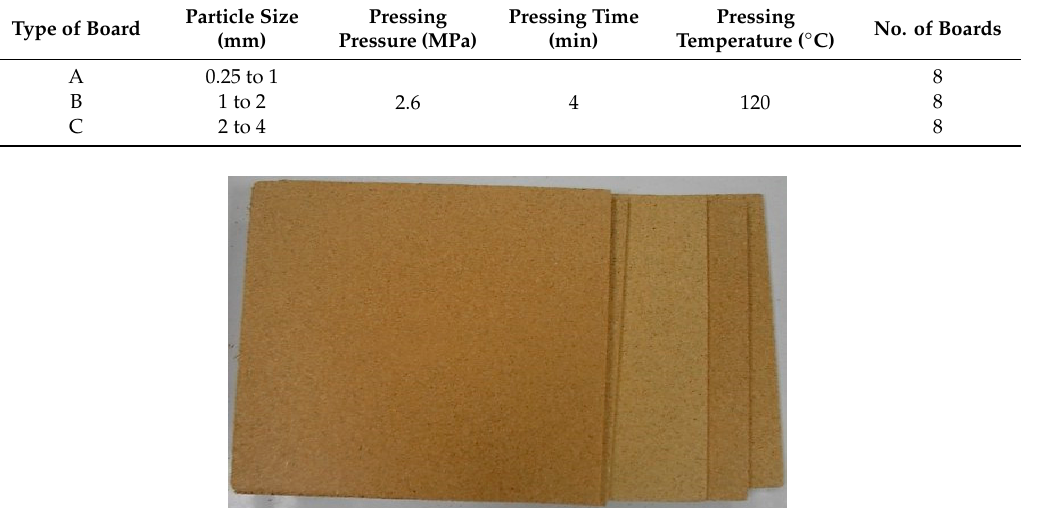
Figure 1. Type A giant reed boards manufactured.